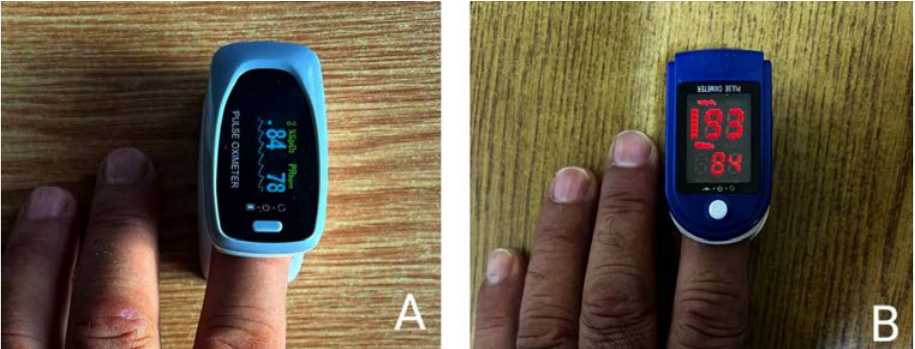
Figure 4. Daytime SaO2 before surgery ( A ) and two weeks after surgery and APAP therapy ( B ). Secondary polycythemia, highlighted by increased hemoglobin and hematocrit, has been rectified after treatment implementation. Following three months under therapeutic measures, hematocrit decreased by almost 10% (from 56.2 to 47.2%) and hemoglobin by approximately 2 g/d (from 17.9 to 16 g/dL).